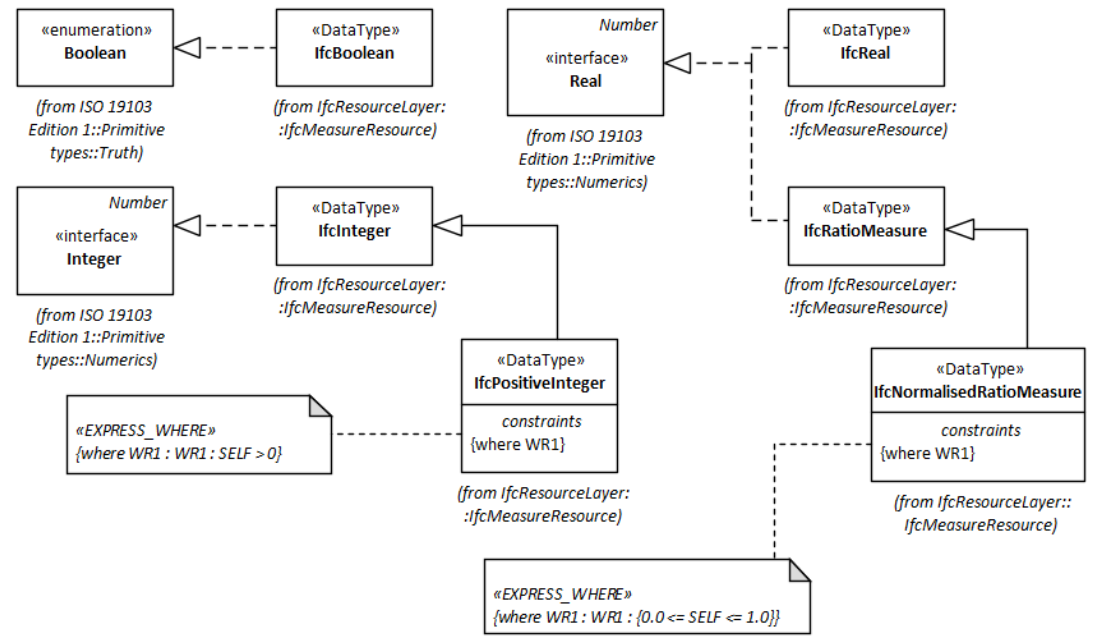
Figure 4. UML class diagram showing examples of IFC simple datatypes as realizations of ISO 19103 datatypes.